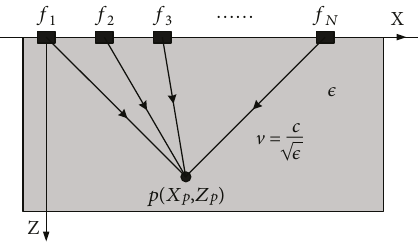
Figure 2: Model of GPR based on